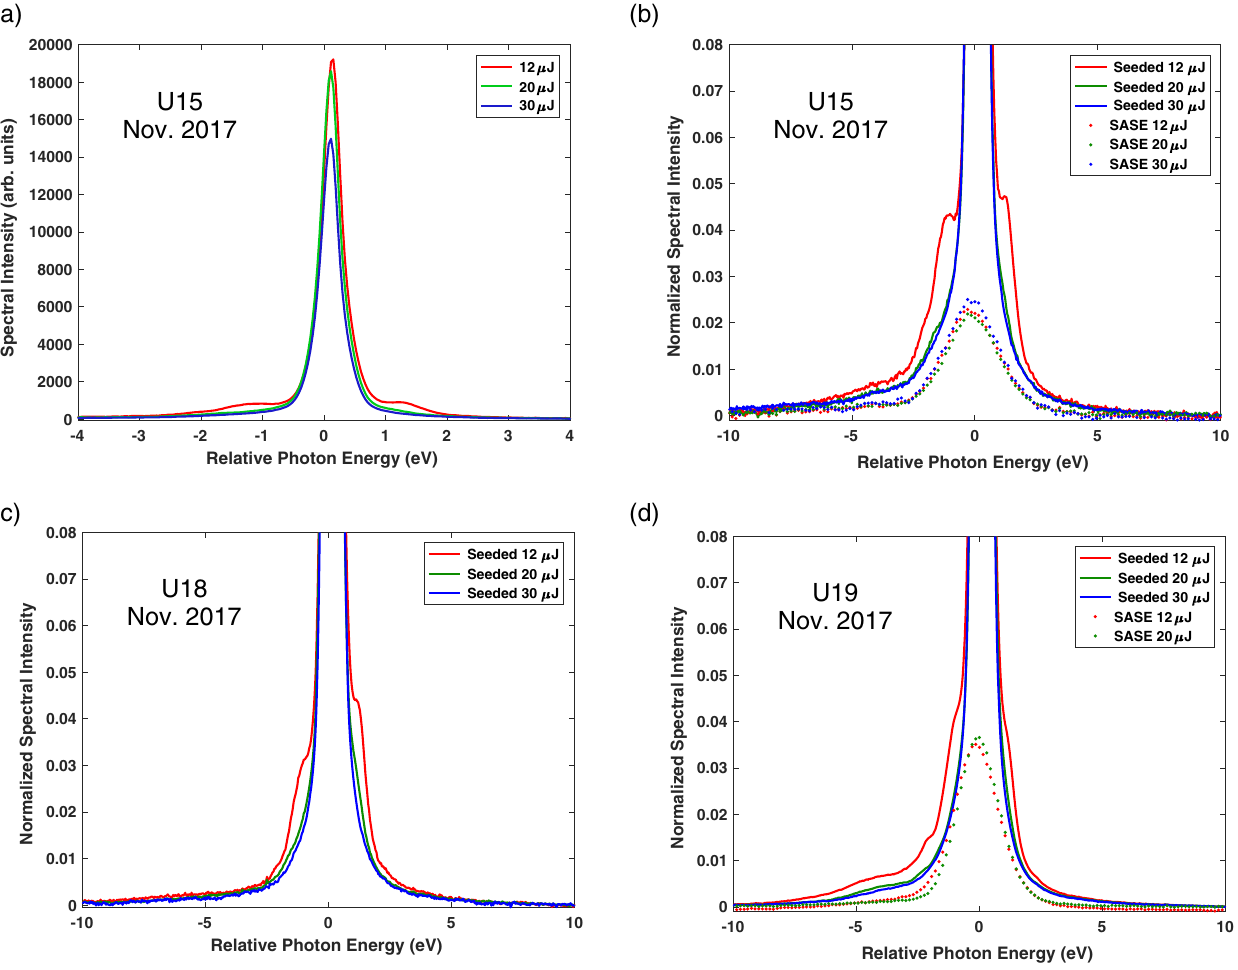
FIG. 11. Average self-seeded and SASE spectra obtained in November 2017 at various laser heater energies for 3 different undulator lengths. With the exception of (a), the spectra are normalized to the peak amplified seed intensity at each LH